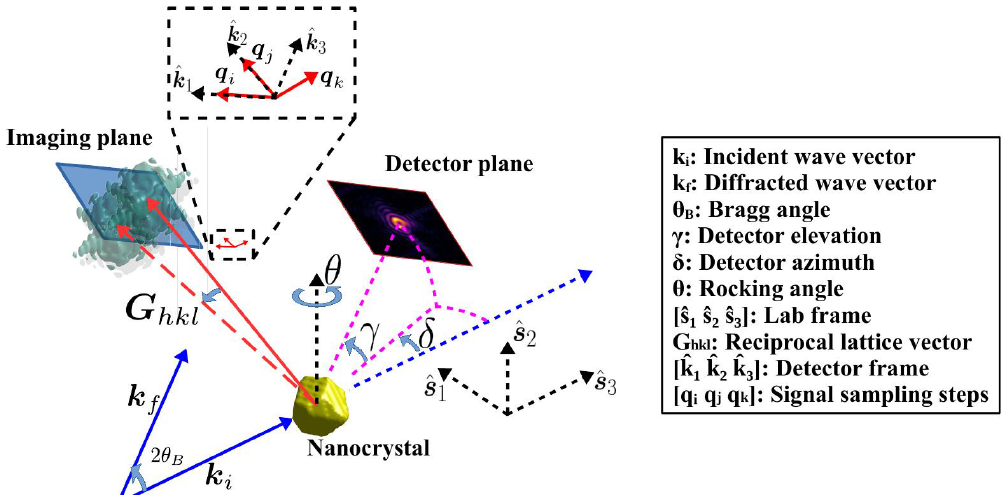
Figure 2. BCDI schematic with all the essential degrees of freedom and the relevant coordinate frames of